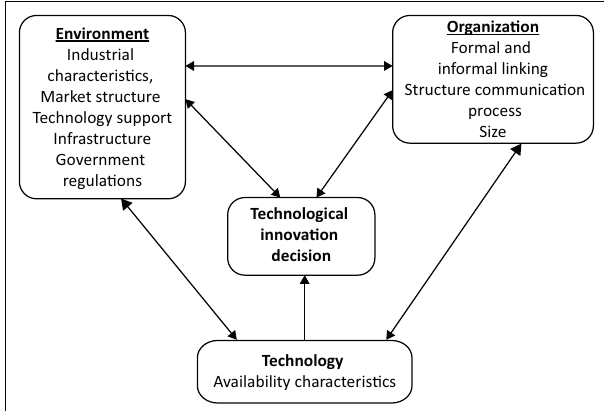
FIGURE 1: Technological, organisational and environmental